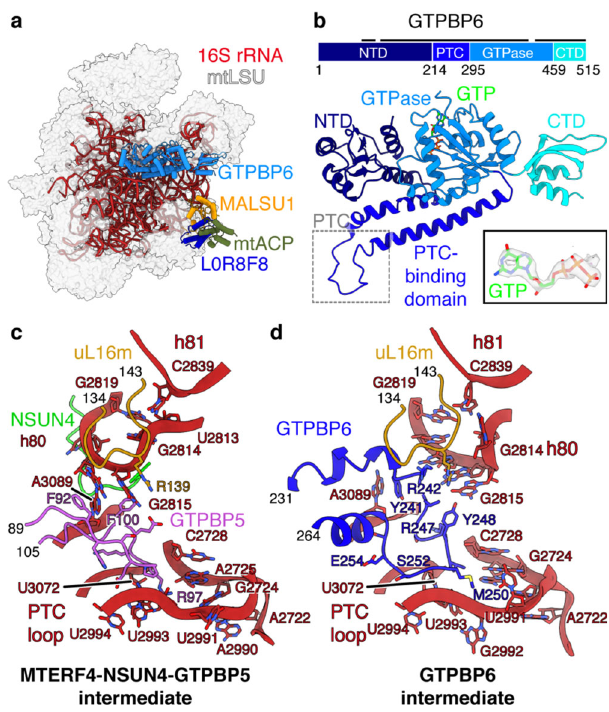
Fig. 3 GTPBP6 binding causes rearrangements in the PTC. a Cryo-EM structure of the GTPBP6-bound large mitoribosomal subunit (mtLSU) assembly intermediate (dataset 2). Depiction as in Fig. 1a with GTPBP6 in marine. b Structure of human GTPBP6. The protein is depicted schematically on top, with domain annotation indicated by coloring and residue numbers. The black bar above represents regions modeled in the structure. The density for the bound GTP is shown as indent. c , d Rearrangements in the peptidyl transferase center (PTC) upon GTPBP6 binding. The PTC region is shown enlarged in the MTERF4-NSUN4-GTPBP5 ( c ) and the GTPBP6 ( d ) mtLSU assembly intermediates. The rRNA and proteins are shown as cartoons, with coloring as in Fig. 2 and uL16m in ocher. NTD N-terminal domain, CTD C-terminal